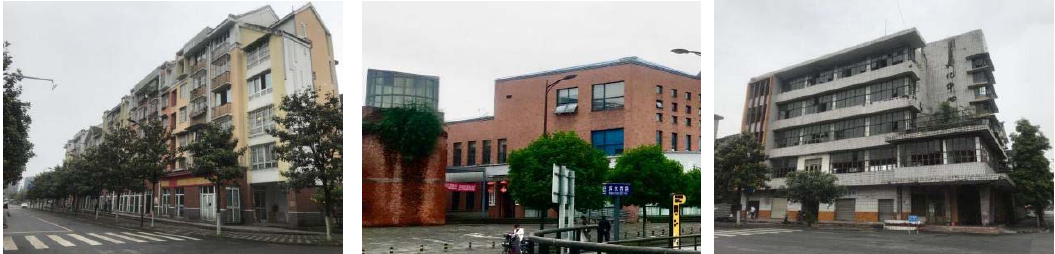
Figure 5. Residential building color tendency.